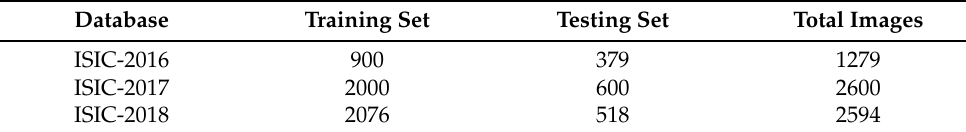
Table 2. Datasets’ division into test and train